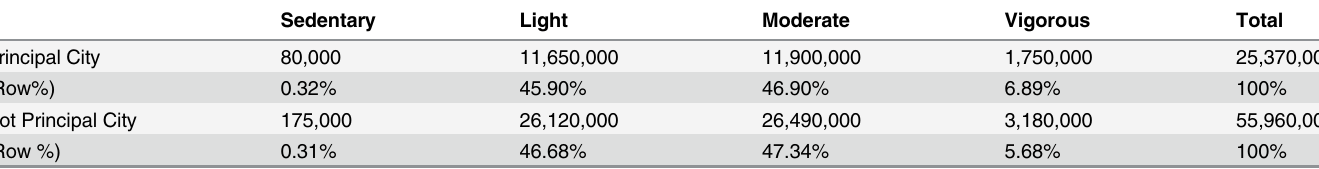
Table 3. Frequency of Highest Activity Level Observed on Diary Day by Principal City Status (Weighted to Represent US